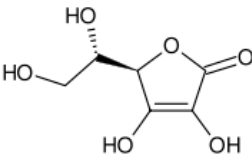
Figure 1. Chemical structure of ascorbic acid.